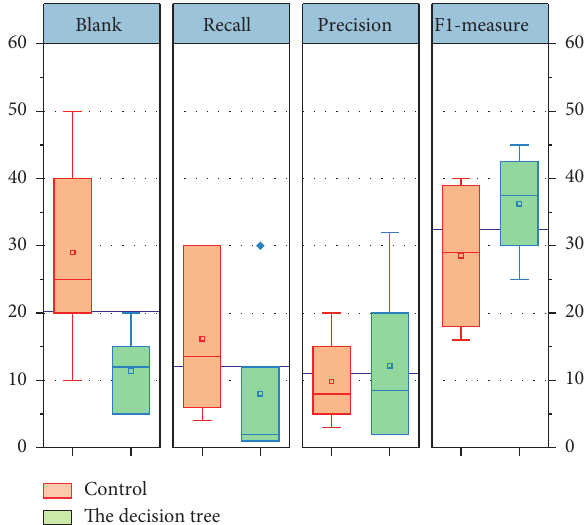
Figure 6: Comparison of the prediction effects of the four types of models.